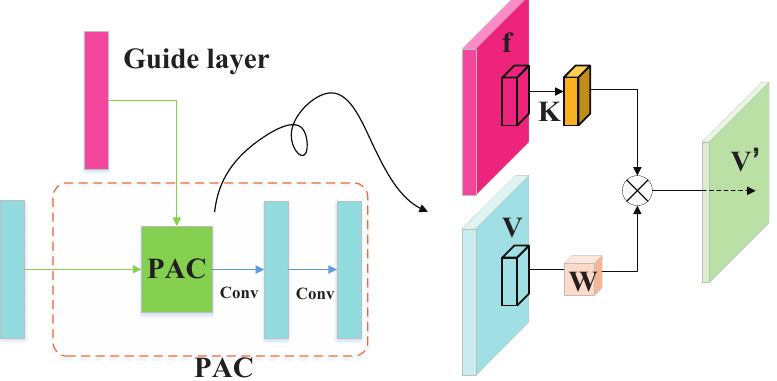
Figure 5. PAC Module. PAC achieves spatial adaptability through the guide layer because each feature of the guide layer is not limited to a fixed